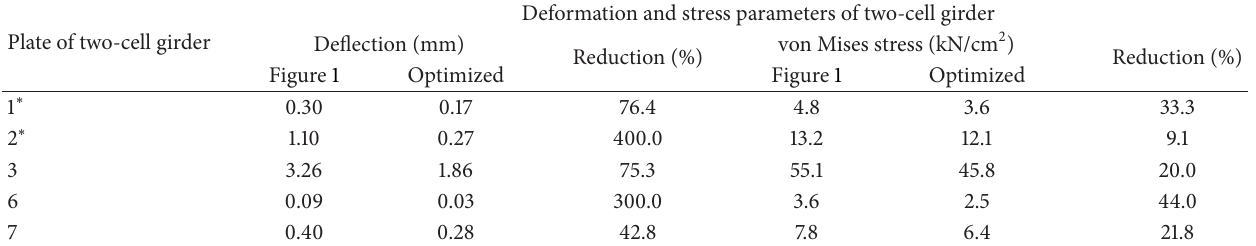
Table 1: Comparative analysis of results of the two-cell box girder.